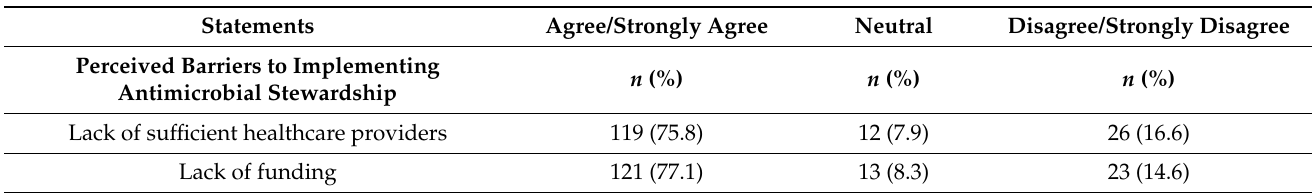
Table 4. Assessment of healthcare providers’ perception of the barriers to delivering functional and effective antimicrobial stewardship programs ( n =